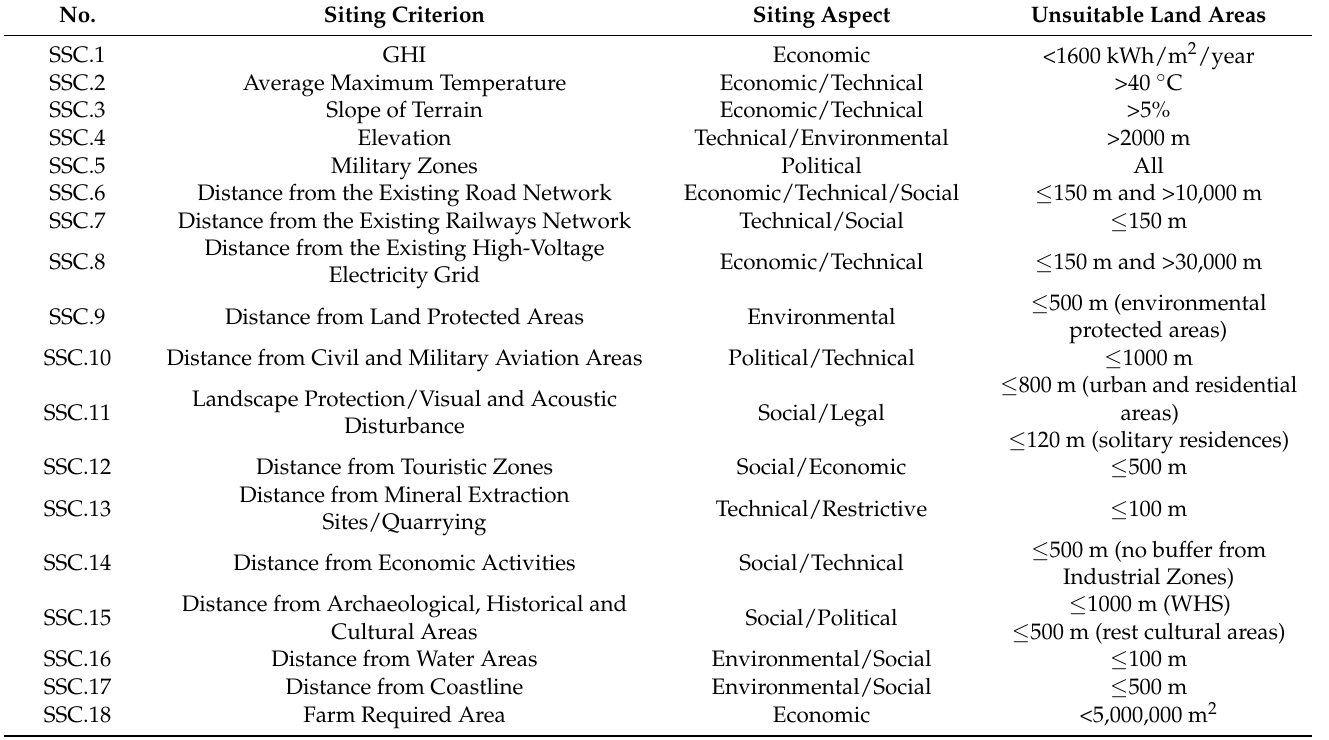
Table 3. Siting Criteria (SC) and their incompatibility zones for large-scale Photovoltaic Farms’ (PVFs’)